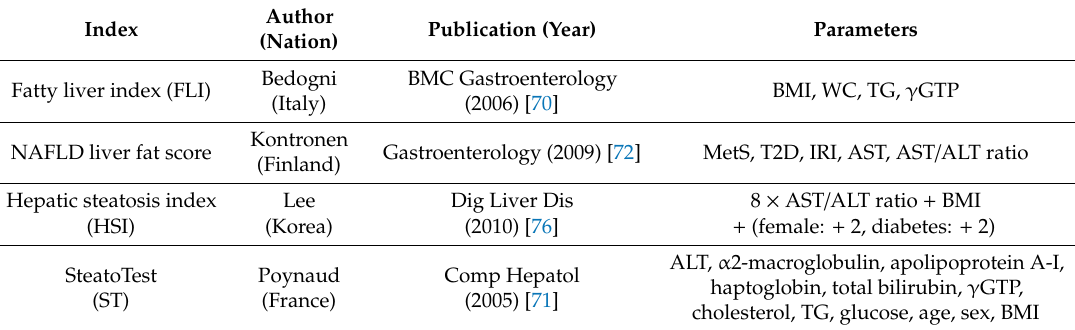
Table 2. Non-invasive tests (NITs) for predicting steatosis in hepatic